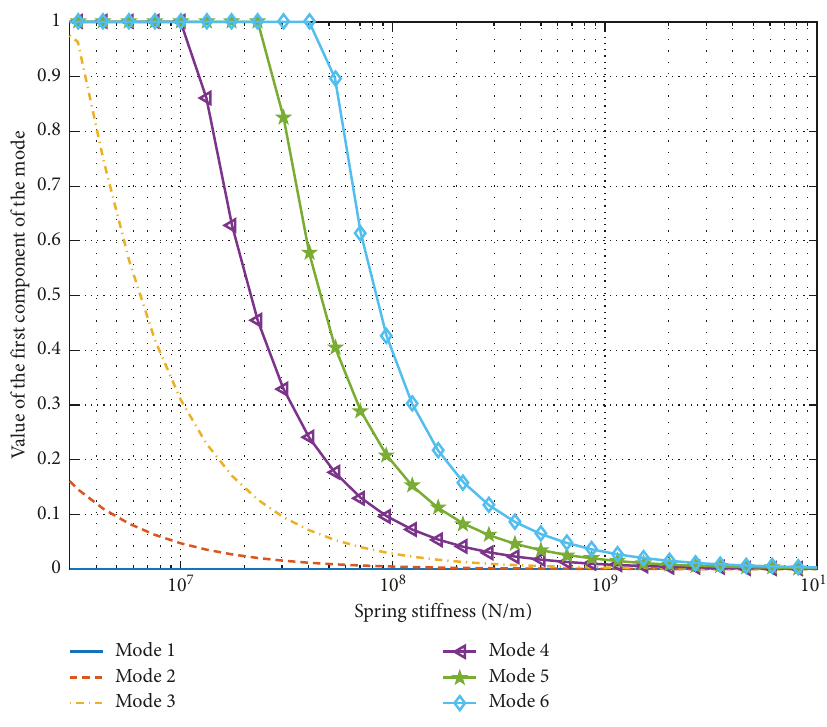
Figure 6: First component of the predicted mode shapes for different values of Δ K